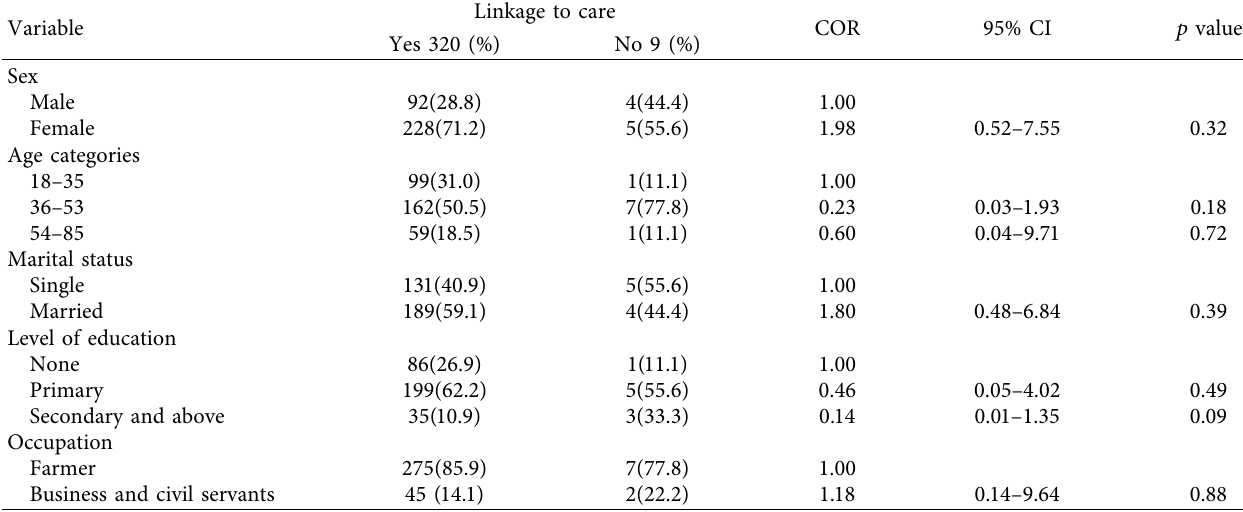
Table 2: Association of sociodemographic characteristics and linkage to care following community-level